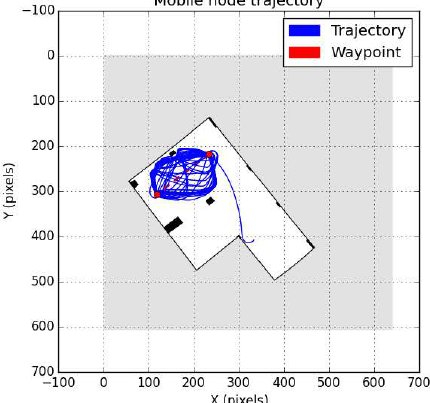
Figure 3. Trajectory of mobile node in Strasbourg